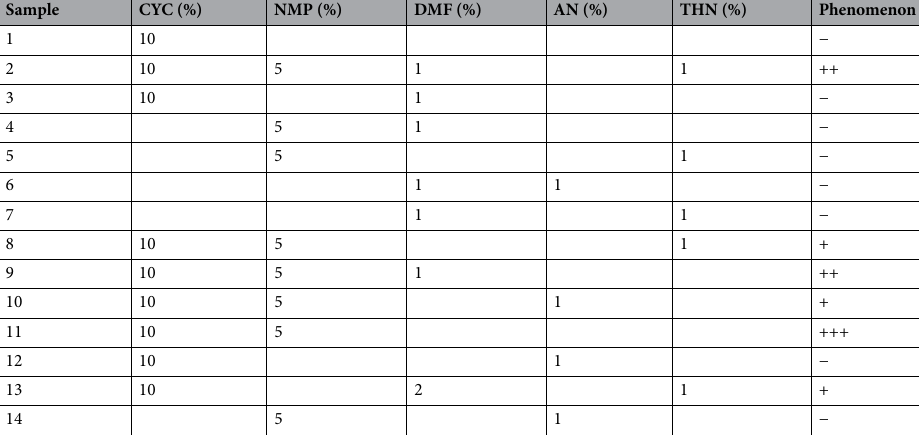
Table 1. Selection of solvent type and dosage (%: mass fraction). −, original pesticide hardly dissolved; +, original pesticide partially dissolved; ++, original pesticide mostly dissolved, or a solid precipitate formed after completely dissolving at room temperature; +++, original pesticide completely dissolved, and no solid precipitated at room temperature. NMP, N -Methyl-2-pyrrolidone; AN, acetonitrile; THN, tetrahydronaphthalene; CYC, cyclohexanone.